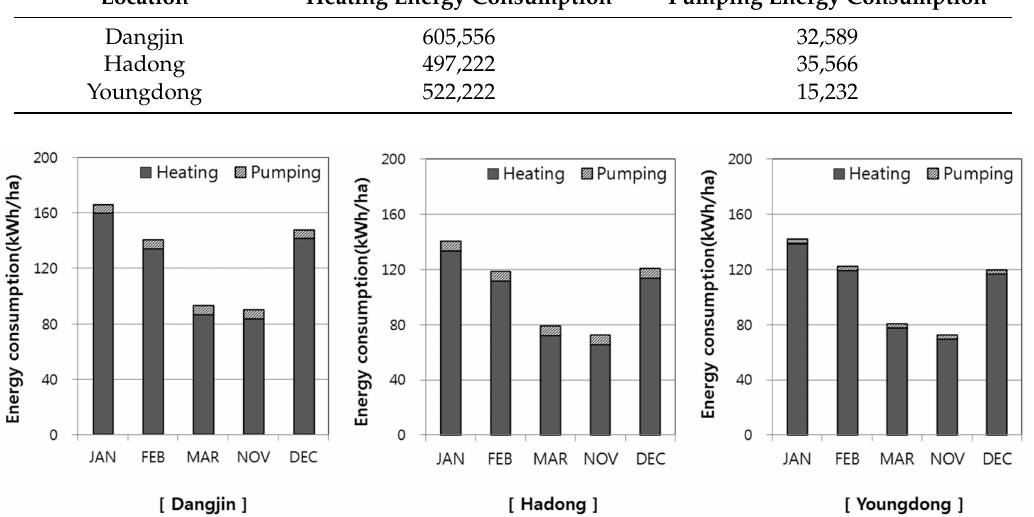
Figure 8. Heating and pumping energy